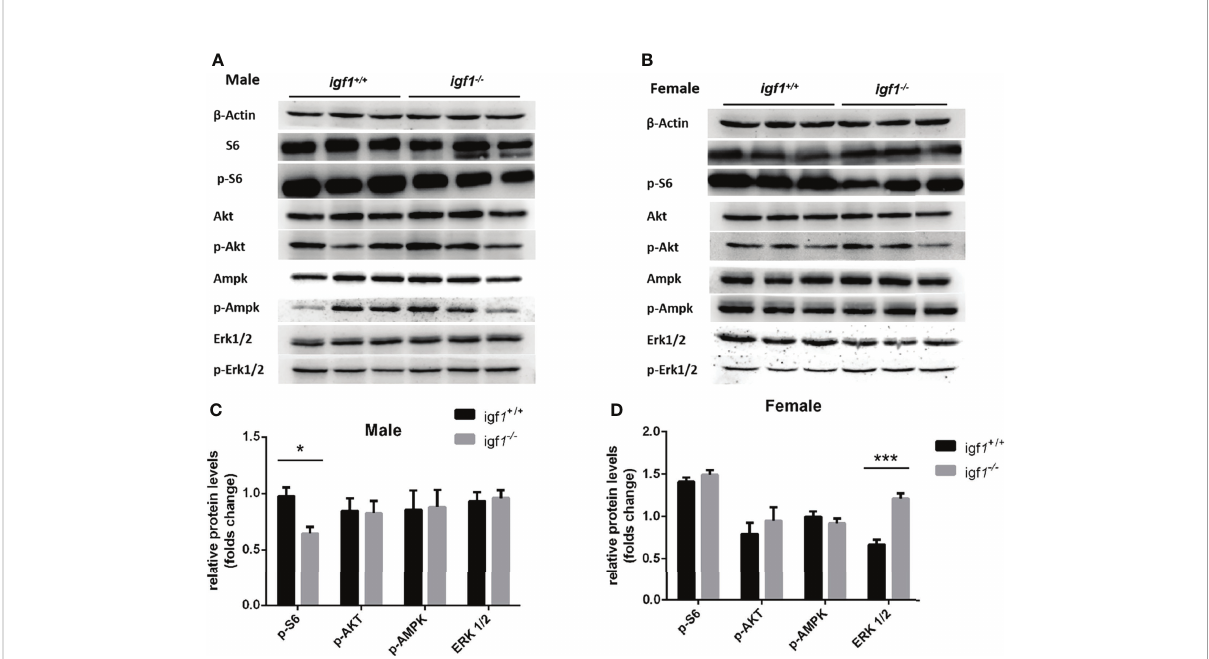
FIGURE 7 The phosphorylation levels of several key kinases in the hepatic tissue of igf1 -de fi cient fi sh. (A, B) Western blot analysis of hepatic actin, p-S6, Akt, p-Akt, AMPK, p-AMPK, Erk1/2, and p-Erk1/2 in igf1 -de fi cient male (A) and female (B) fi sh. (C, D) The data were analyzed by quantifying the protein results using the ImageJ software. Relative expression of p-S6, p-Akt, p-AMPK, and p-Erk1/2 in male (C) and female (D) zebra fi sh. * P < 0.05; *** P < 0.001.